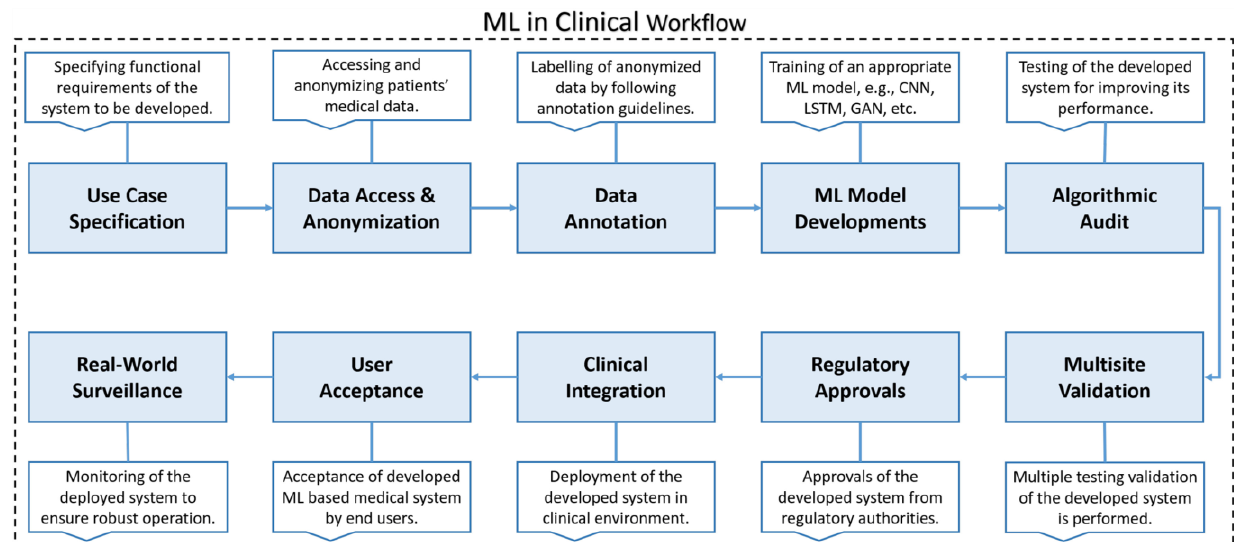
Figure 23. The illustration of major phases for development of machine learning based healthcare systems. Abbreviations used: ML, Machine Learning; CNN, Convolutional Neural Network; LSTM, Long Short Term Memory networks; and GAN, Generative Adversarial Network [64].